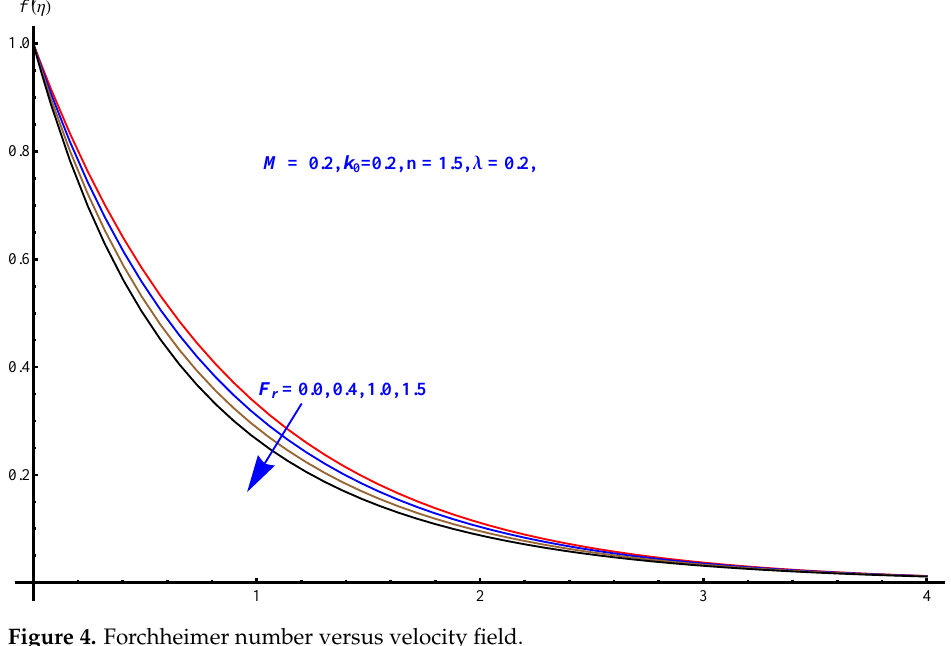
Figure 4. Forchheimer number versus velocity field.